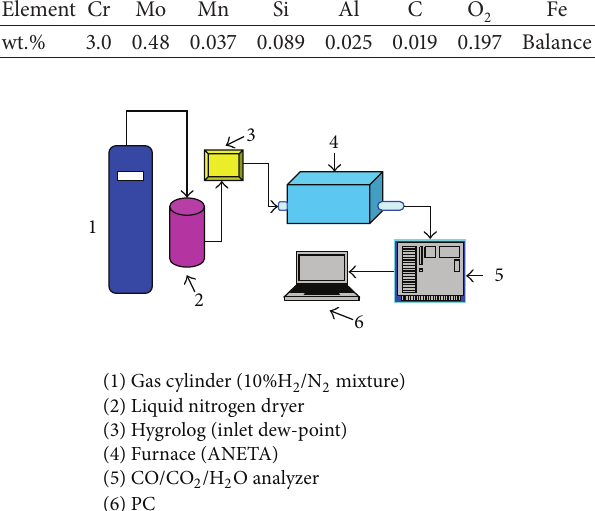
Figure 1: Scheme of sintering atmosphere monitoring setup, sinter- ing furnace, and PC processing of the monitored